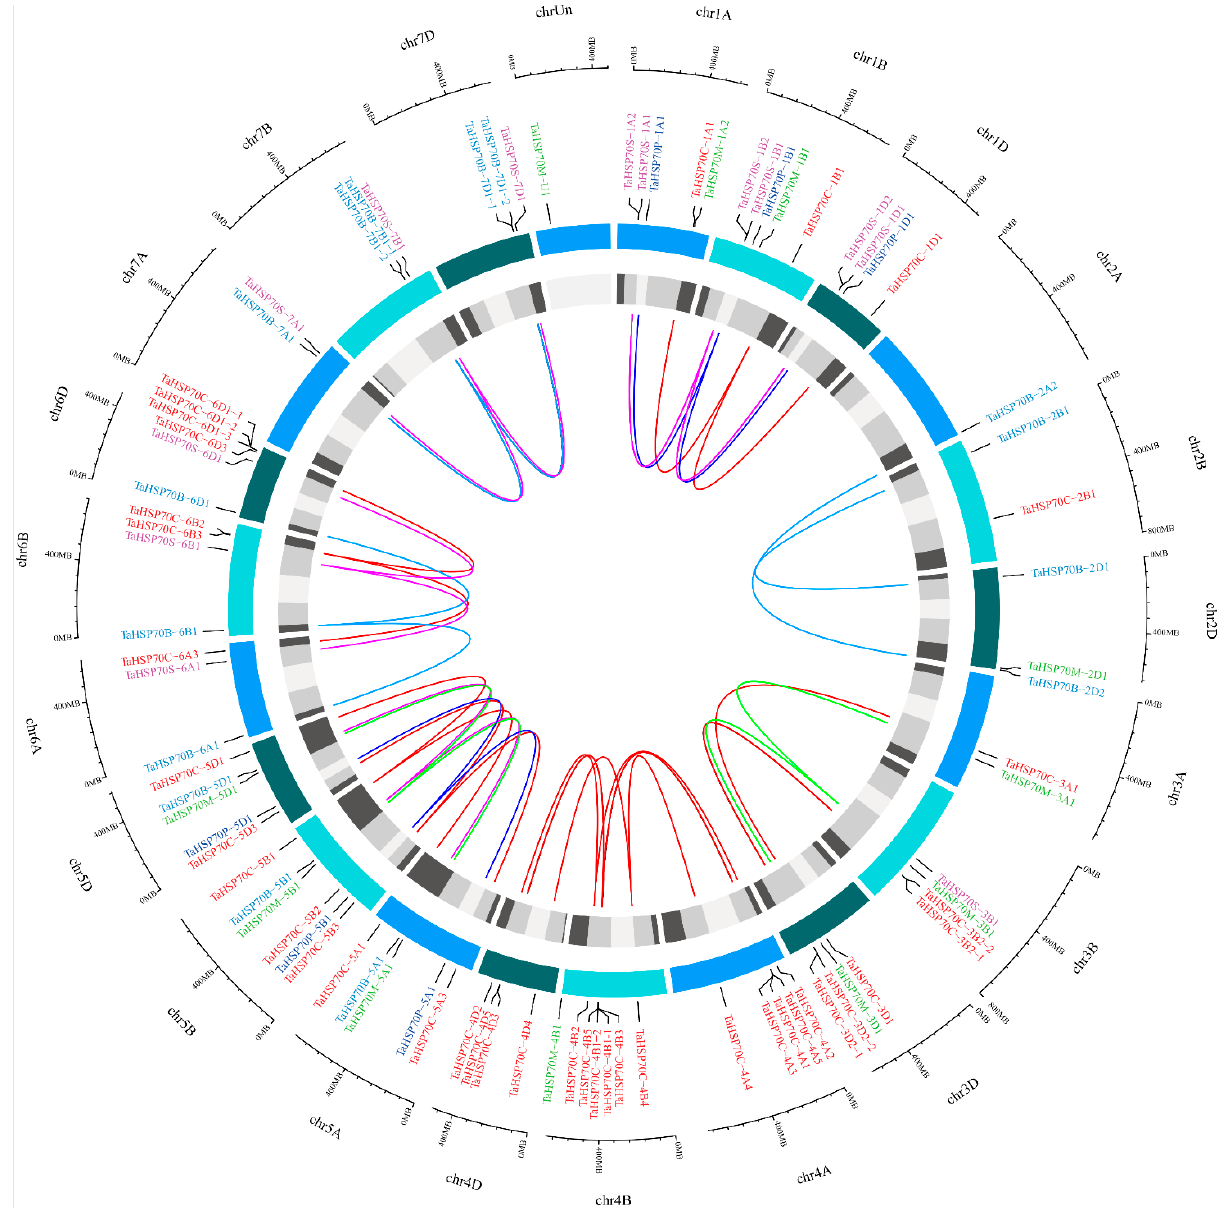
Figure 4. Distribution and homeologous groups of TaHSP70s in the wheat genome. The outer track represents chromosomes and the inner track represents chromosome segments. Homeologous TaHSP70s were linked and colored based on subfamilies. Table 1. Groups of homeologous HSP70s in hexaploid wheat.